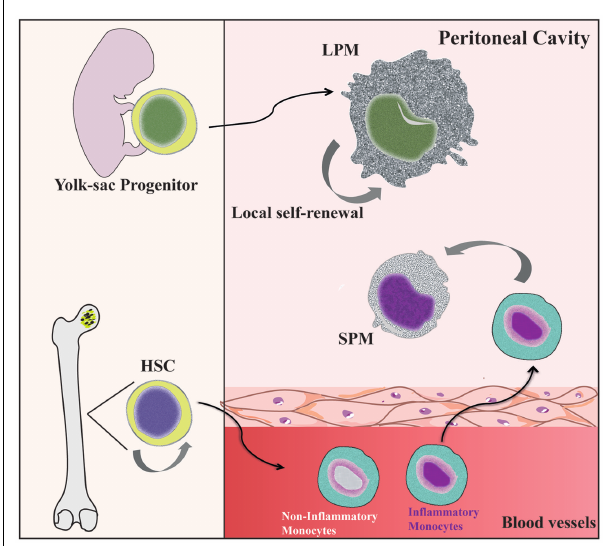
FIGURE 1 | Distinct origin of peritoneal macrophage subsets . SPMs are generated from hematopoietic stem cells (HSC) in the bone marrow (BM) by differentiation of inflammatory blood monocytes (31, 40). However, LPMs appear to be originated from progenitors from yolk sac and independent of hematopoietic progenitors (69). Local proliferation of LPMs ensures homeostatic maintenance by self-renewal (36).